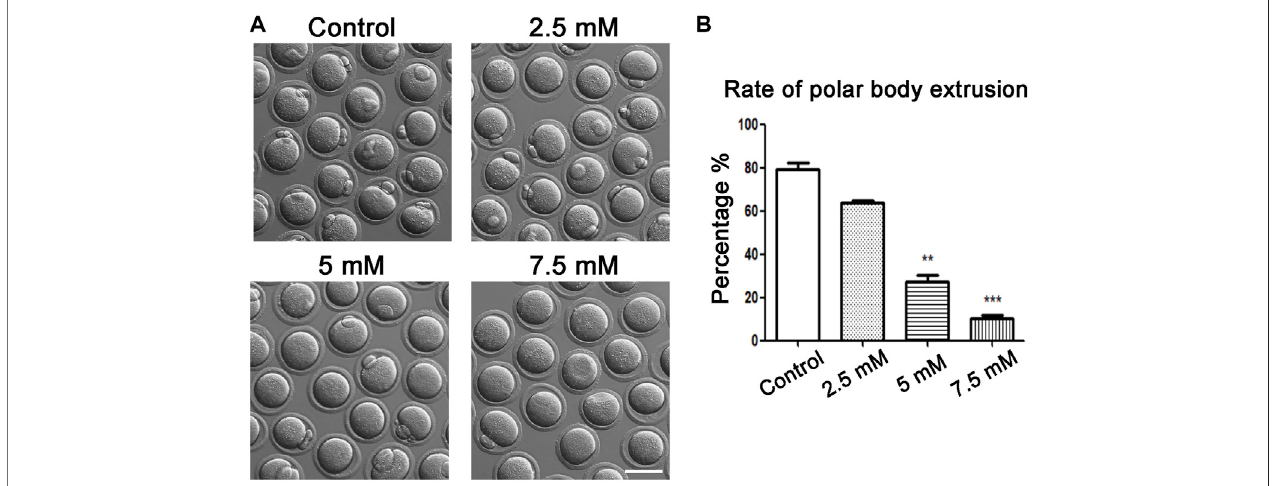
FIGURE1| ToxiceffectsofACRonoocytematurationwithdifferentACRdosages. (A) Atypicalpictureofthe fi rstpolarbodyinoocytesafterACRexposure.Inthe controlgroup, mostoocytes extruded thepolar body, while there were few in thetreatmentgroups. Bar = 80 μ m. (B) Therate ofthe fi rst polar body after ACR exposure in mouse oocytes. ** p < 0.01, *** p <